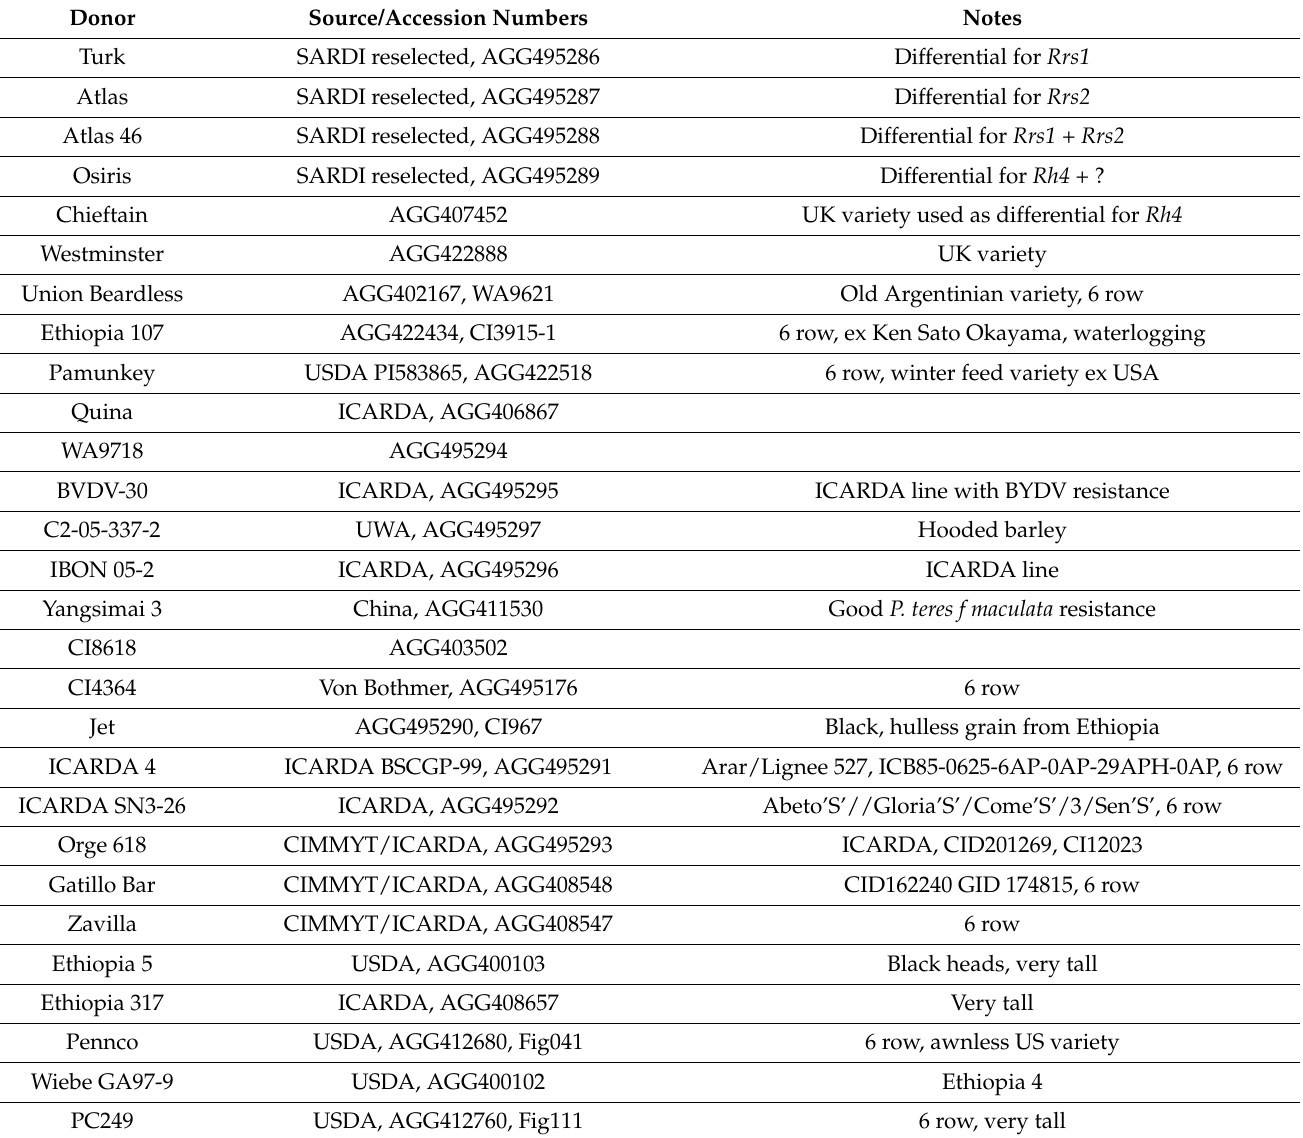
Table 4. Sources of scald resistance, alternative identifiers and other information relating to